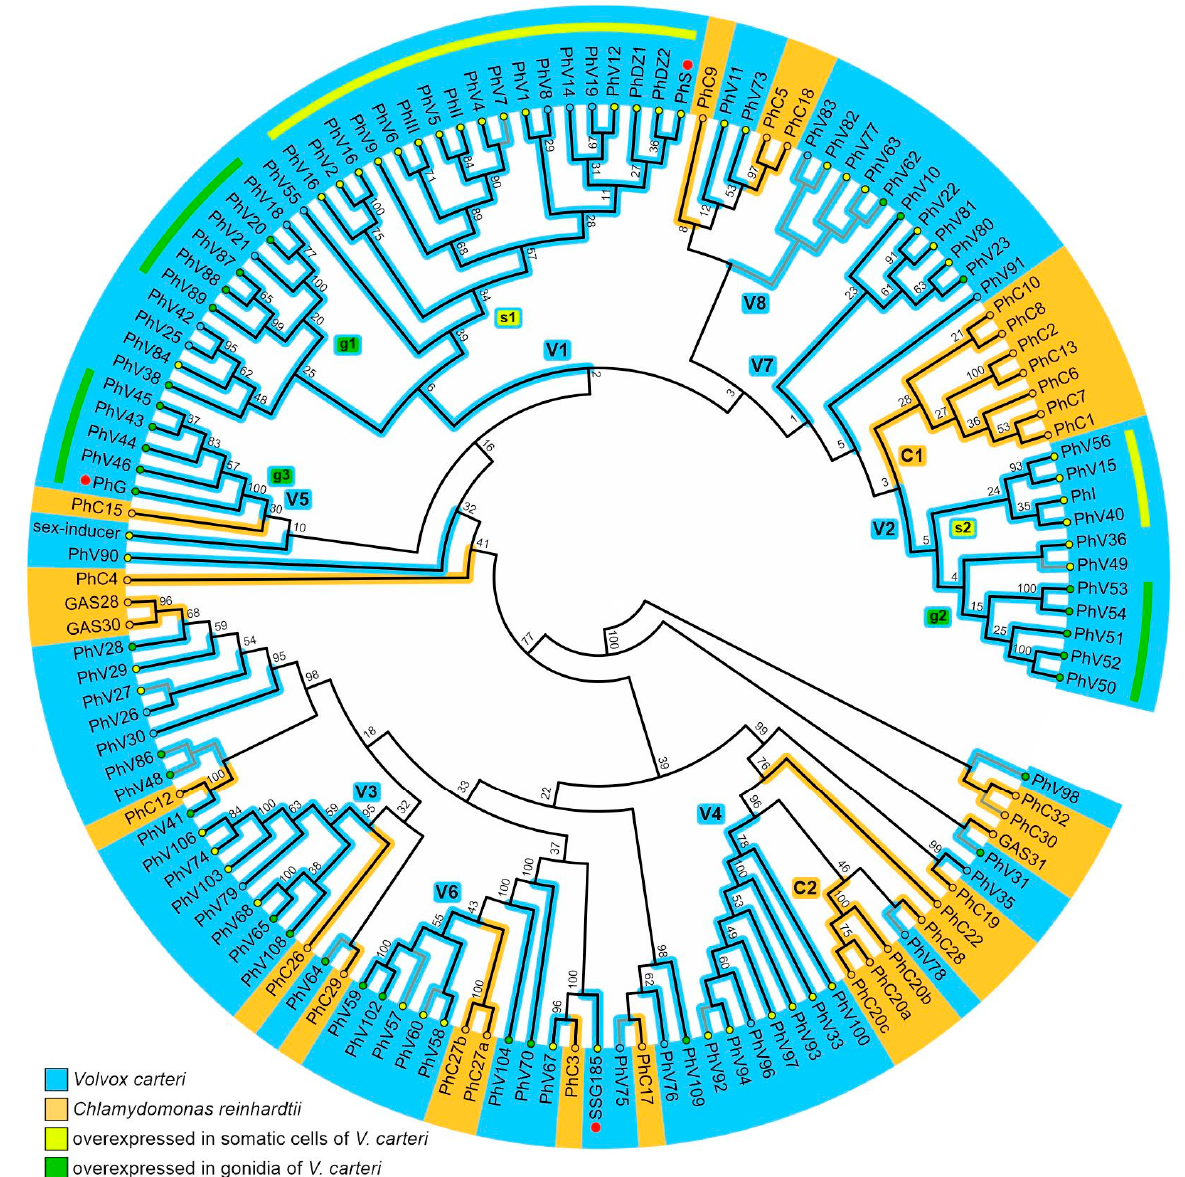
Figure 2. Phylogenetic tree of pherophorins of V. carteri and C. reinhardtii . Sequence relationship between the deduced amino acid sequences of pherophorins of the multicellular species V. carteri (blue) and the unicellular species C. reinhardtii (orange). Red dots indicate the positions of the pherophorins SSG185, PhG and PhS. The unrooted bootstrap consensus tree is based on 10,000 replicates calculated using the neighbor-joining method. The bootstrap values of the branch points are indicated. The tree was calculated using an alignment of the C-terminal domain of the pherophorins. However, with some pherophorins the C-terminal domains were unusable due to issues with their sequences and/or gene models. For those pherophorins, trees based on alignments of the N-terminal domains were analyzed and the pherophorins were added at the corresponding position of the tree (gray lines). Details about all pherophorins are listed in Table S1. In total, 99 pherophorins of V. carteri and 30 pherophorins of C. reinhardtii are shown. Pherophorins that are overexpressed in somatic cells (yellow-filled circles) or gonidia (green-filled circles) of V. carteri are highlighted. Larger sub-branches of V. carteri pherophorins (V1 to V8) and of C. reinhardtii pherophorins (C1 and C2) are indicated. Sub-branches that contain pherophorins that are overexpressed in somatic cells (s1 and s2) or gonidia (g1 to g3) of V. carteri are indicated and highlighted with yellow (somatic cells) or green (gonidia)